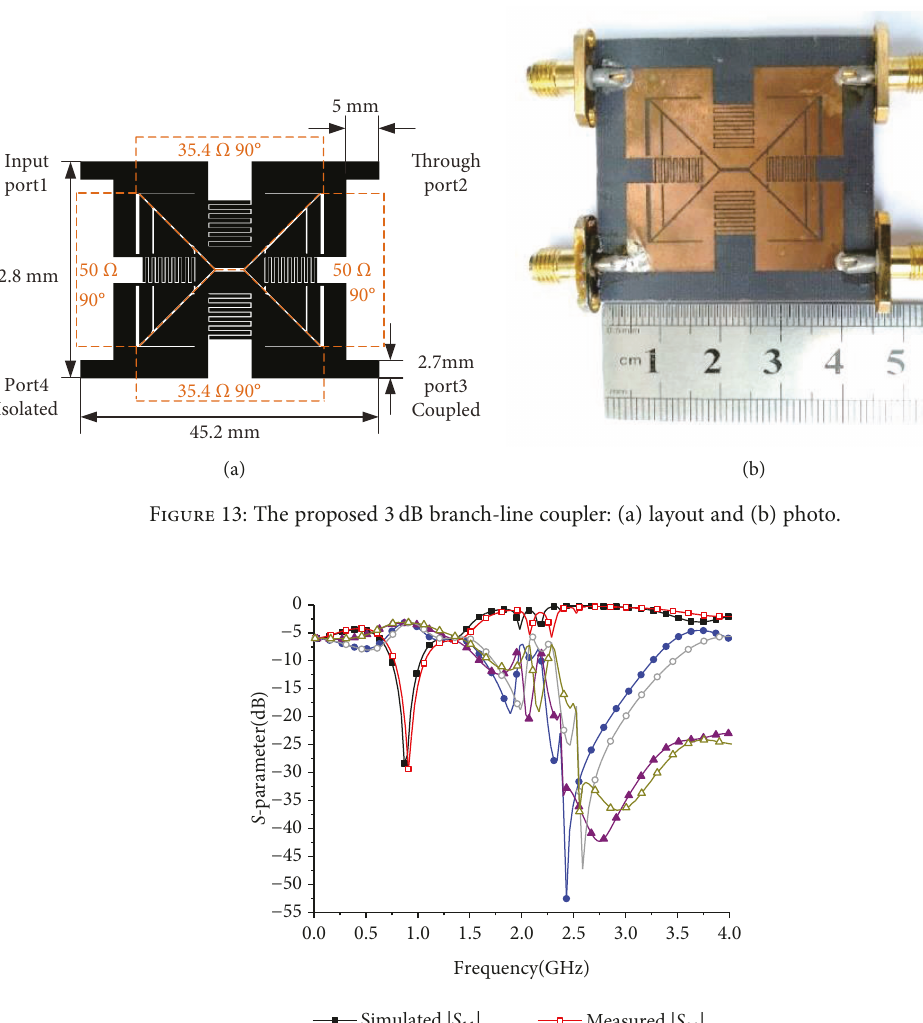
, S , and S of the proposed branch-line coupler. 11 21 31